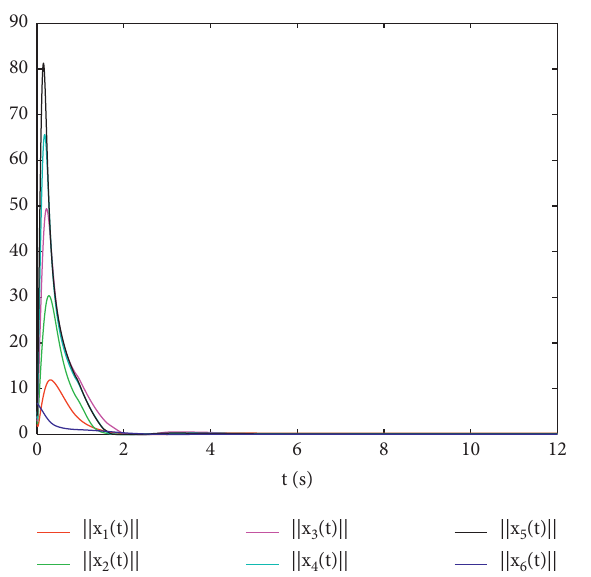
Figure 3: Time evolution of ‖ z